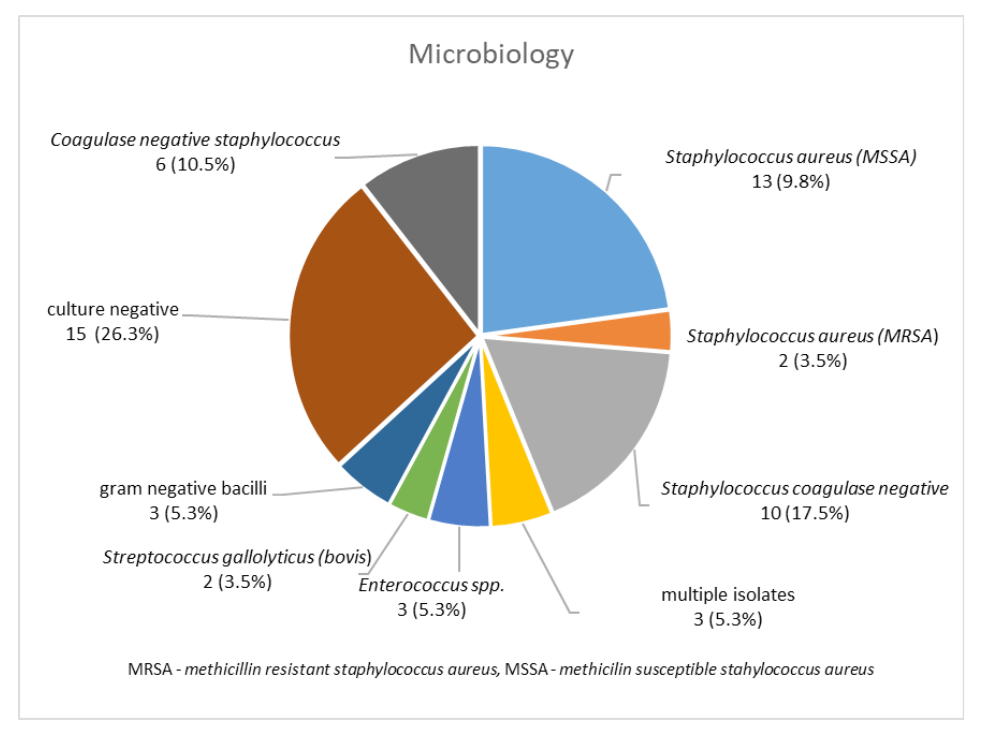
Fig. 1. Microbiology